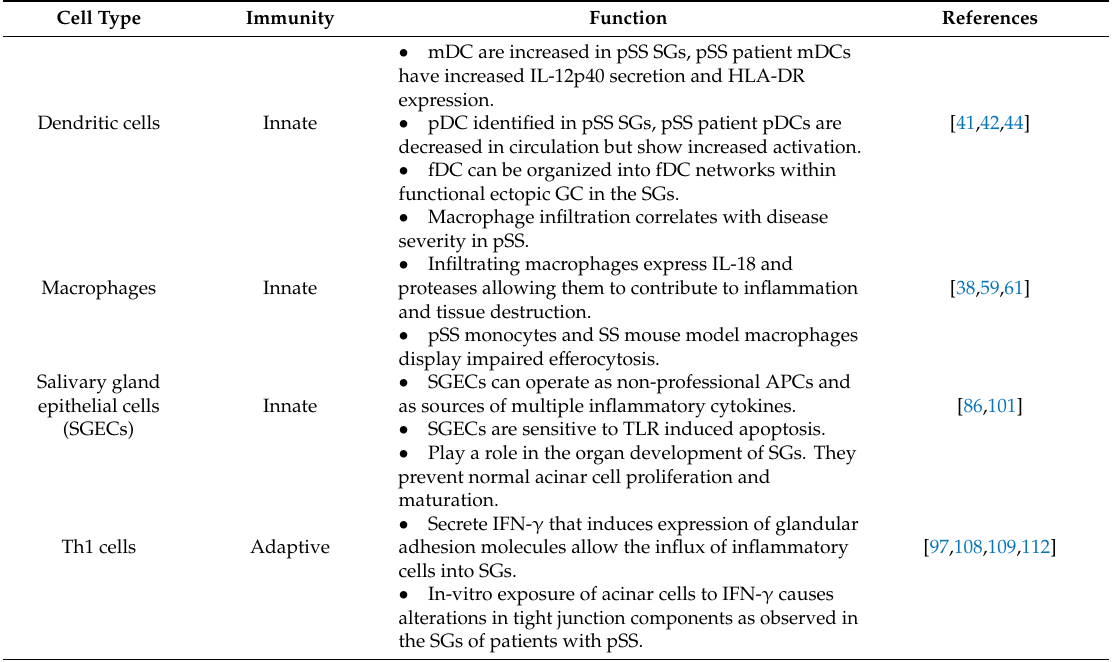
Table 1. Immune cells and their functions involved in